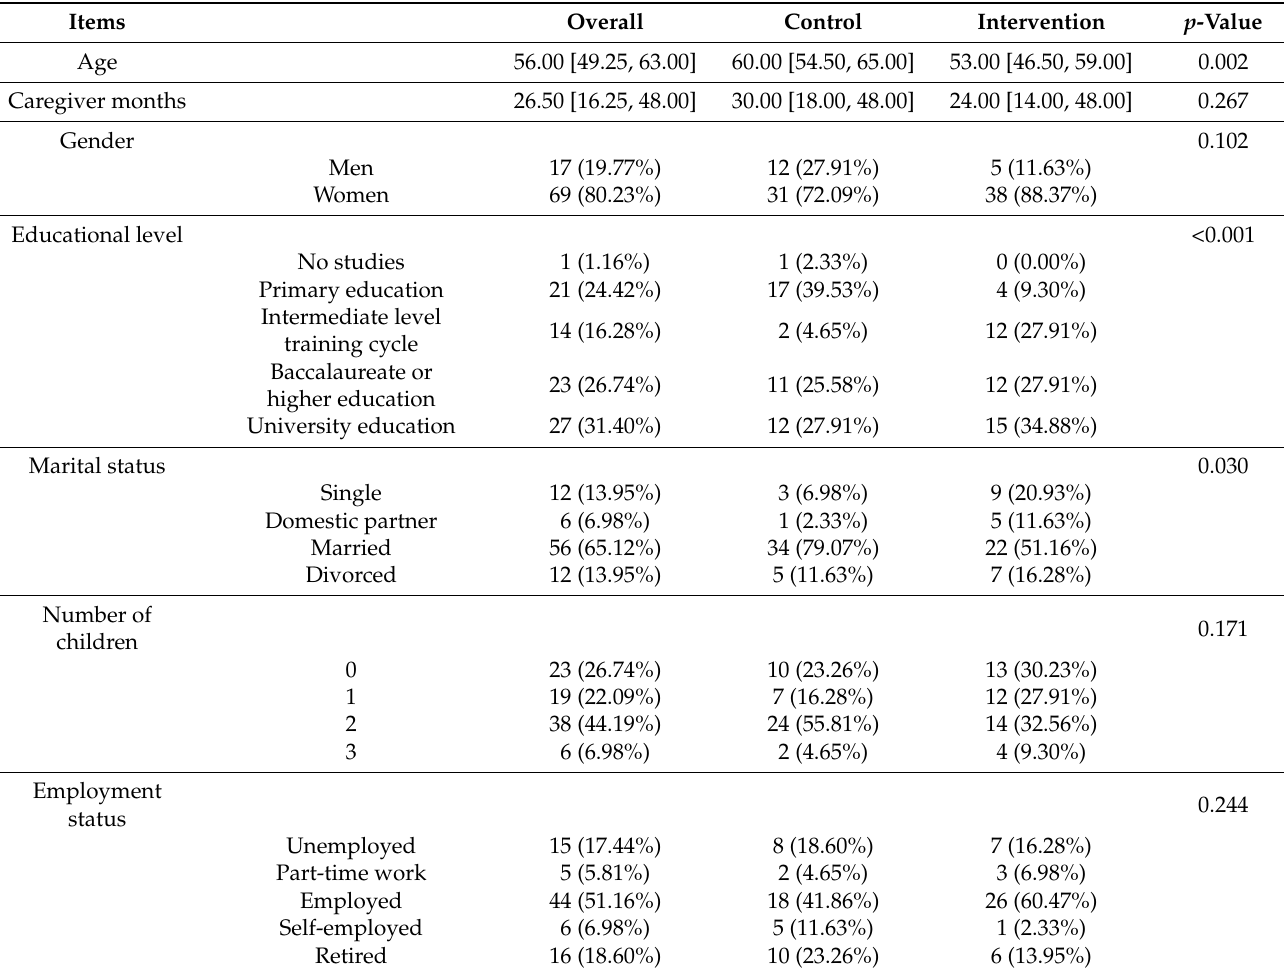
Table 1. Baseline characteristics of the sample, overall and by